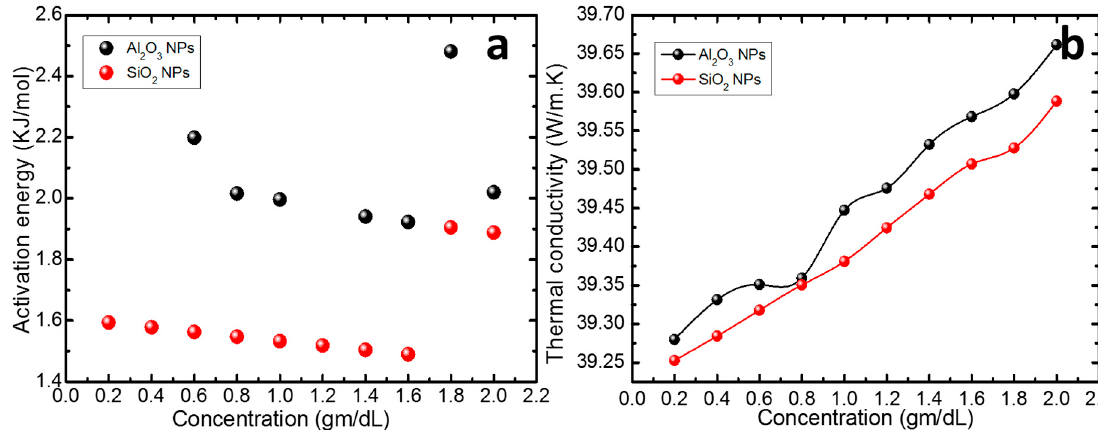
Figure 2. ( a ) Variation of activation energy with concentration ( b ) Variation of thermal conductivity with concentration. In Figure 2b the thermal conductivity data points are joined in terms of concentrations to infer the trend.